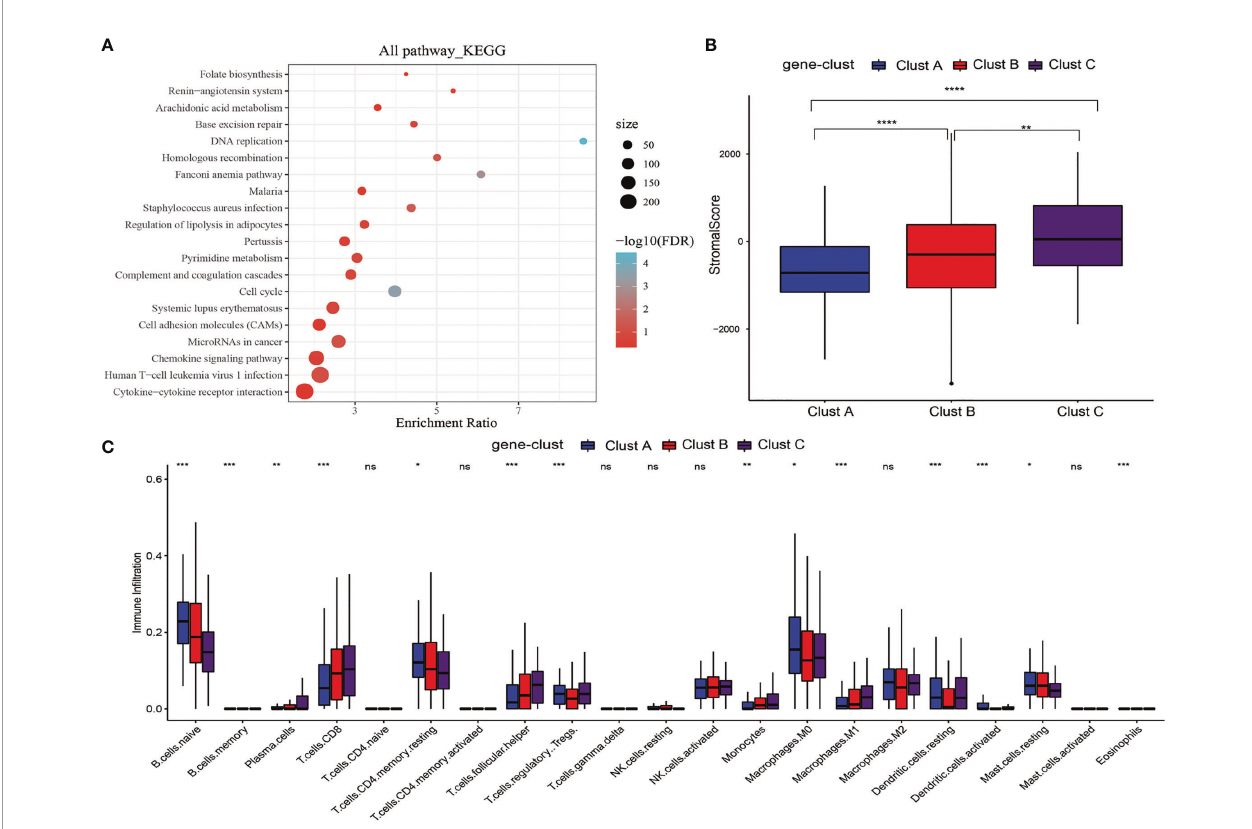
FIGURE 4 | m 5 C gene signature establishment along with functional annotation. (A) KEGG enrichment analysis of 690 DEGs. (B) Levels of stromal scores in three m 5 C gene-cluster subtypes. (C) The levels of in fi ltration of 22 immune cells in three m 5 C gene-cluster subtypes. *, **, ***, **** statistic difference at different levels; ns, no signi fi